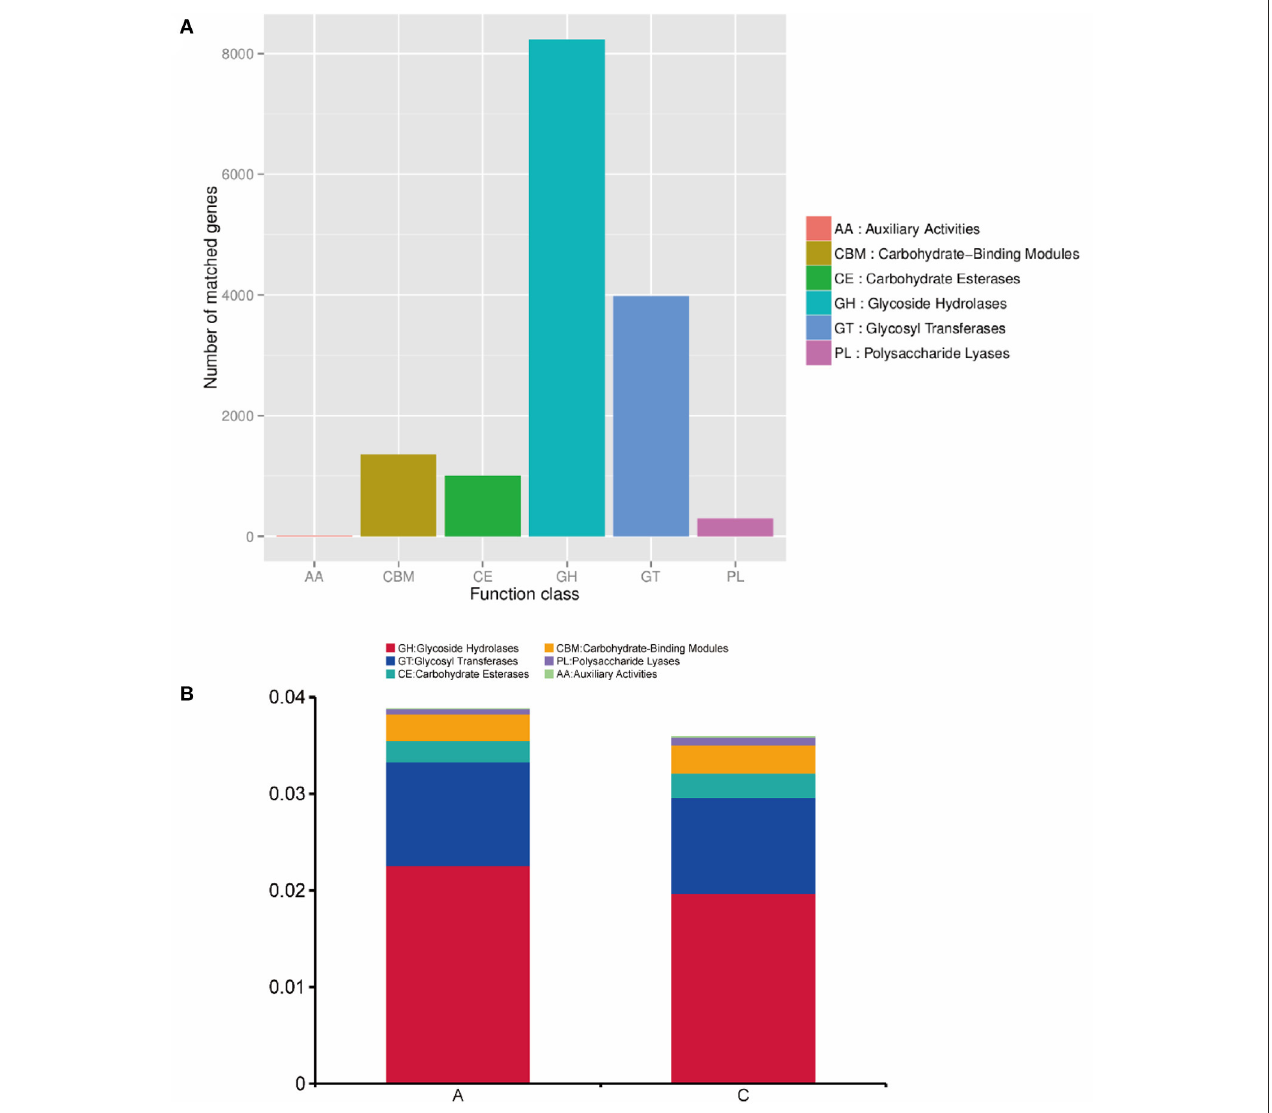
FIGURE7 (A) Statistics of the number of gene annotations based on the CAZy database; (B) the histogram of functional abundance on level 1 based on the CAZy